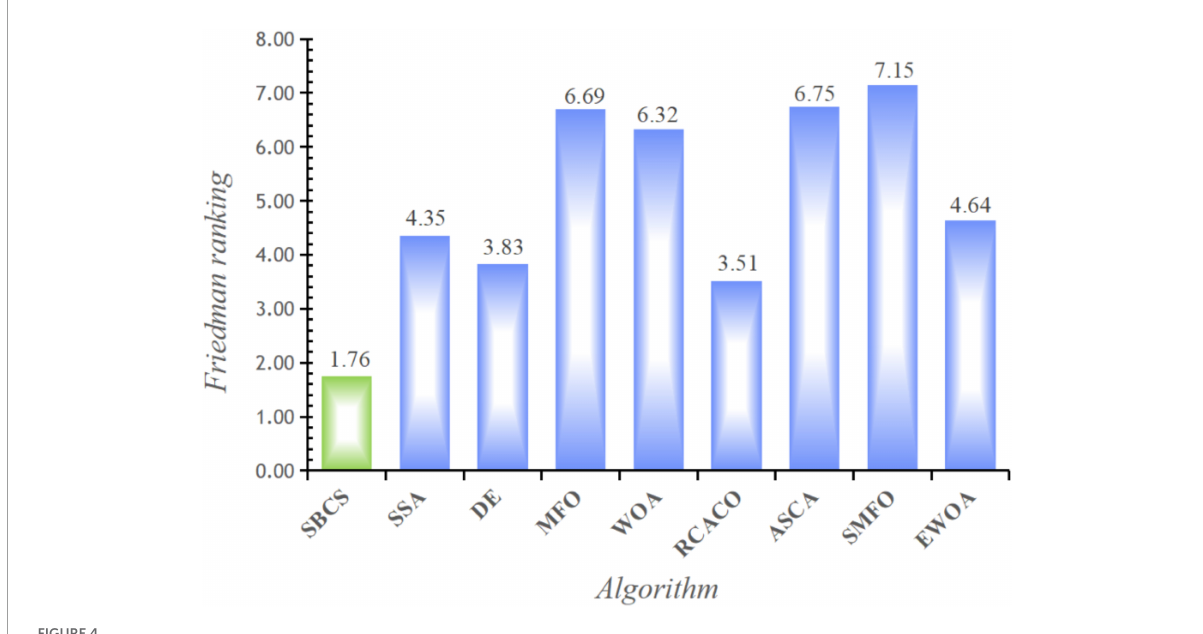
FIGURE4 Comparison results of SBCS and other well-known